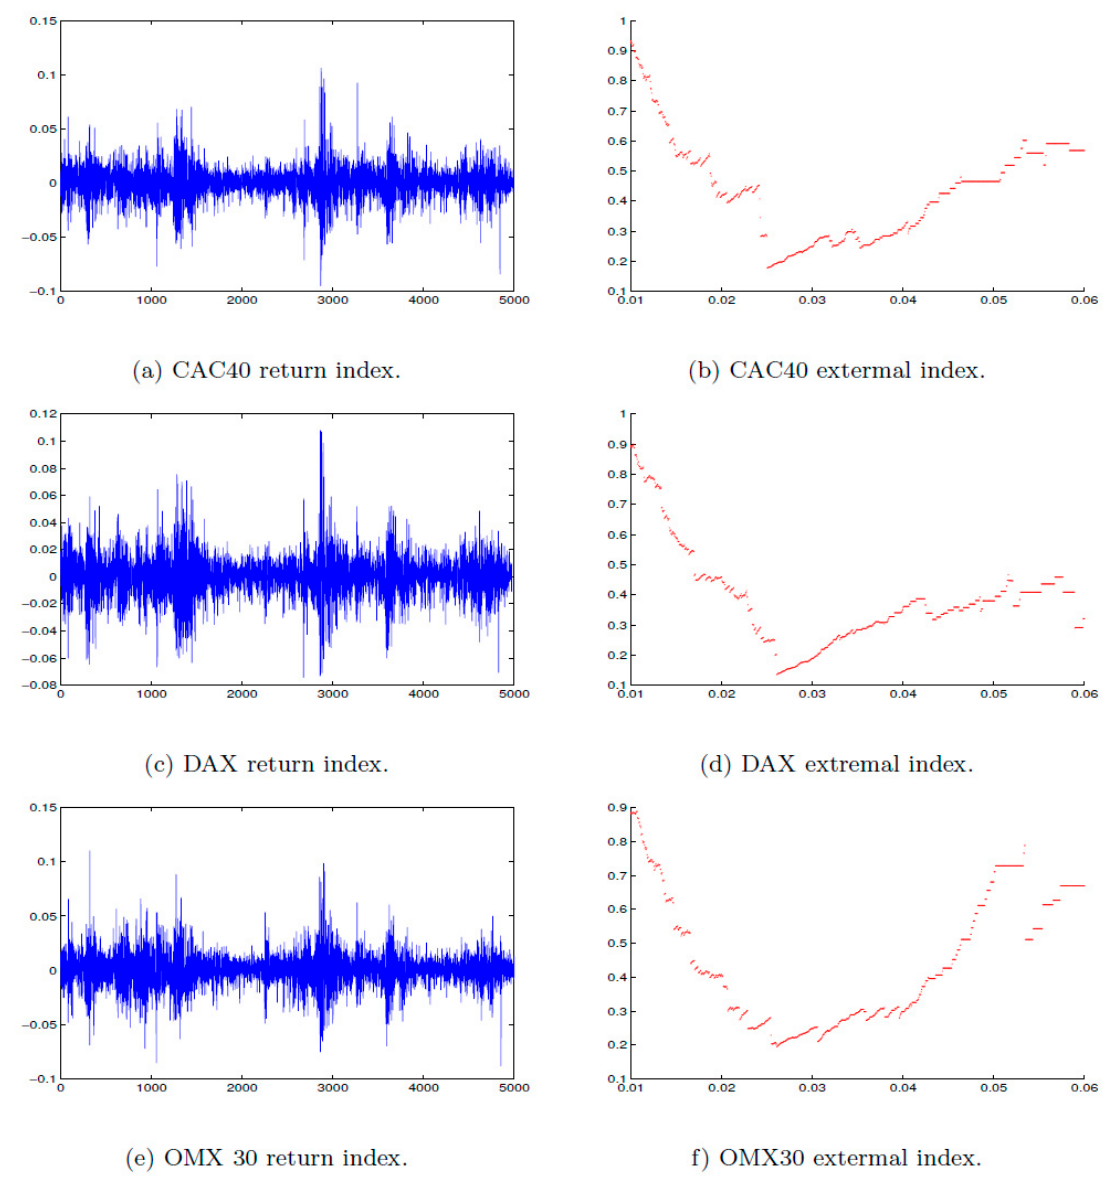
Figure 2. Daily log returns of ( a ) CAC40, ( c ) DAX, ( e ) OMX 30 for the period from 1 July 1997 to 16 January 2017, that consists of an average of ( n = 5000) observations. The estimated extremal index of ( b ) CAC 40, ( d ) DAX, ( f ) OMX 30 at a range of threshold u.